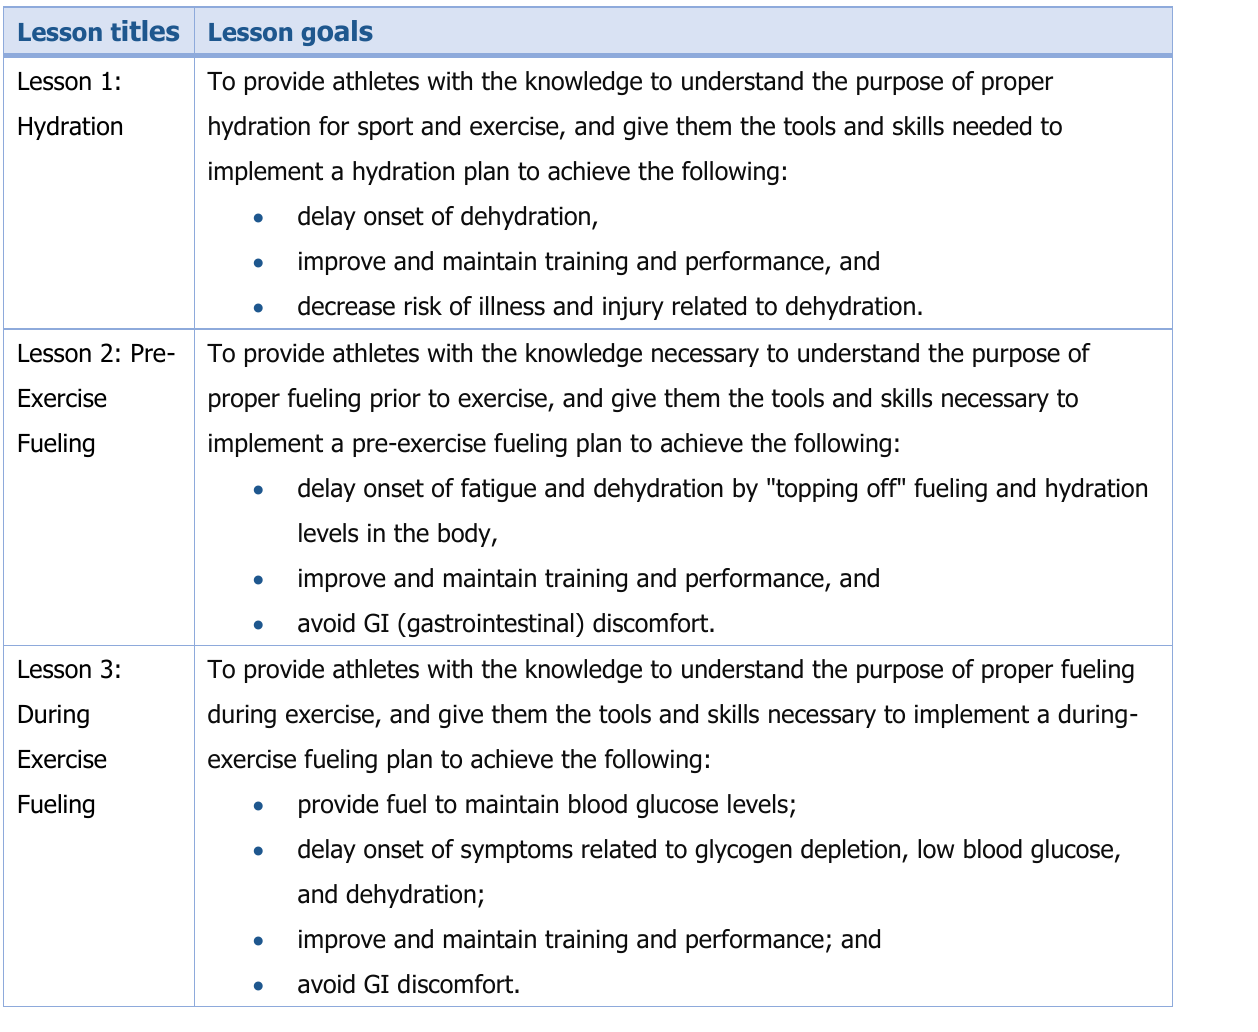
Table 1. WAVE Sport Nutrition Curriculum